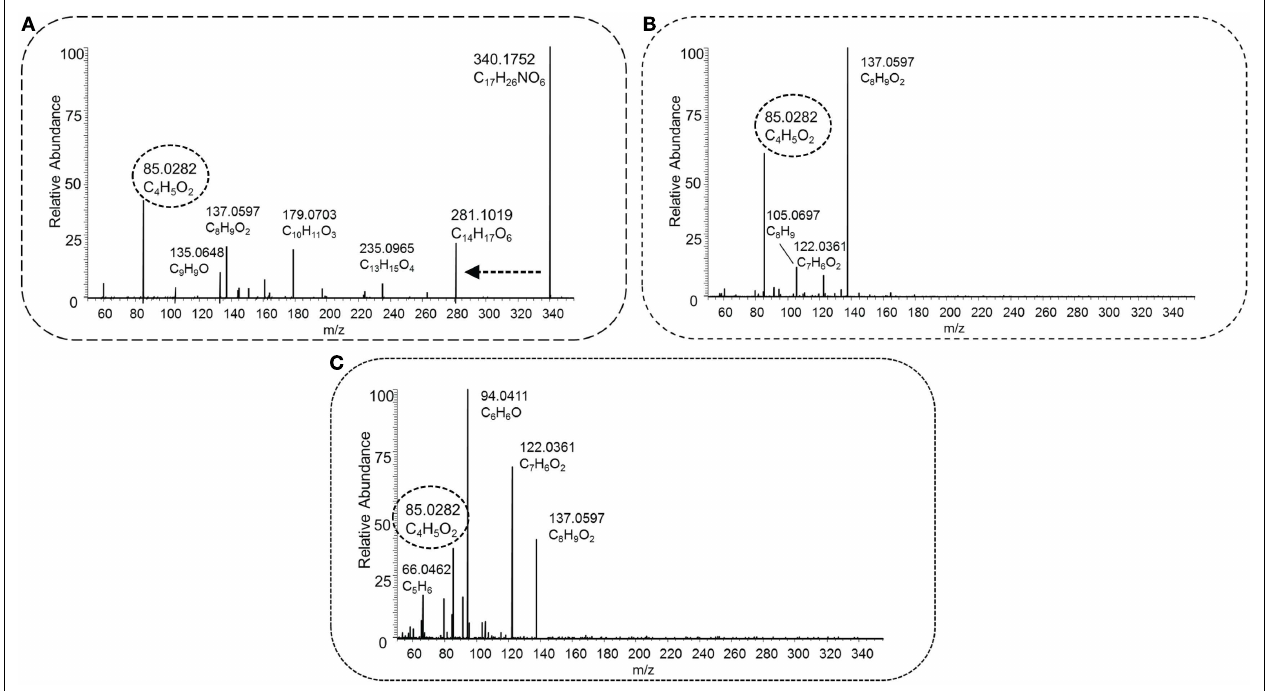
C 17 H 25 NO 6 .The key fragment C 4 H 5 O 2 , marked with a dashed oval, and the neutral loss C 3 H 9 N, indicated by a dashed arrow, occur in the spectra, and this fragmented metabolite could be annotated as an